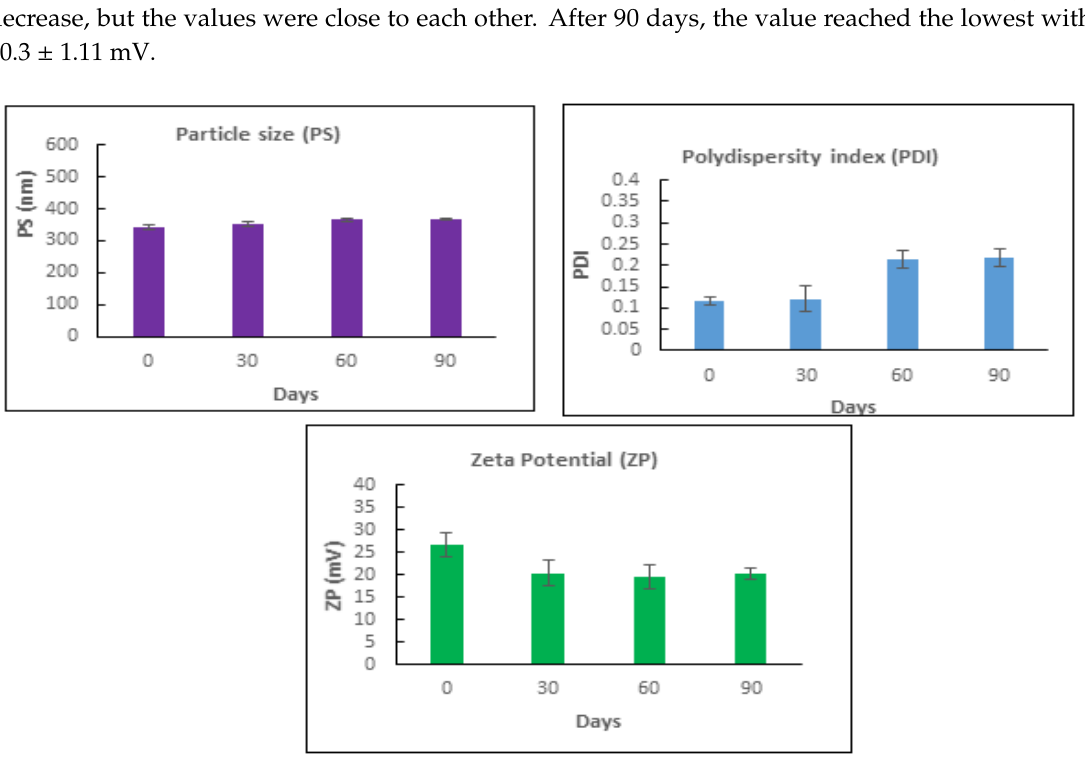
Figure 4. Particle size distribution, shape, and morphology of CS coated RES-PLGA-NPs. ( A ) Transmission electron microscopy (TEM) image ( B ) SEM image.